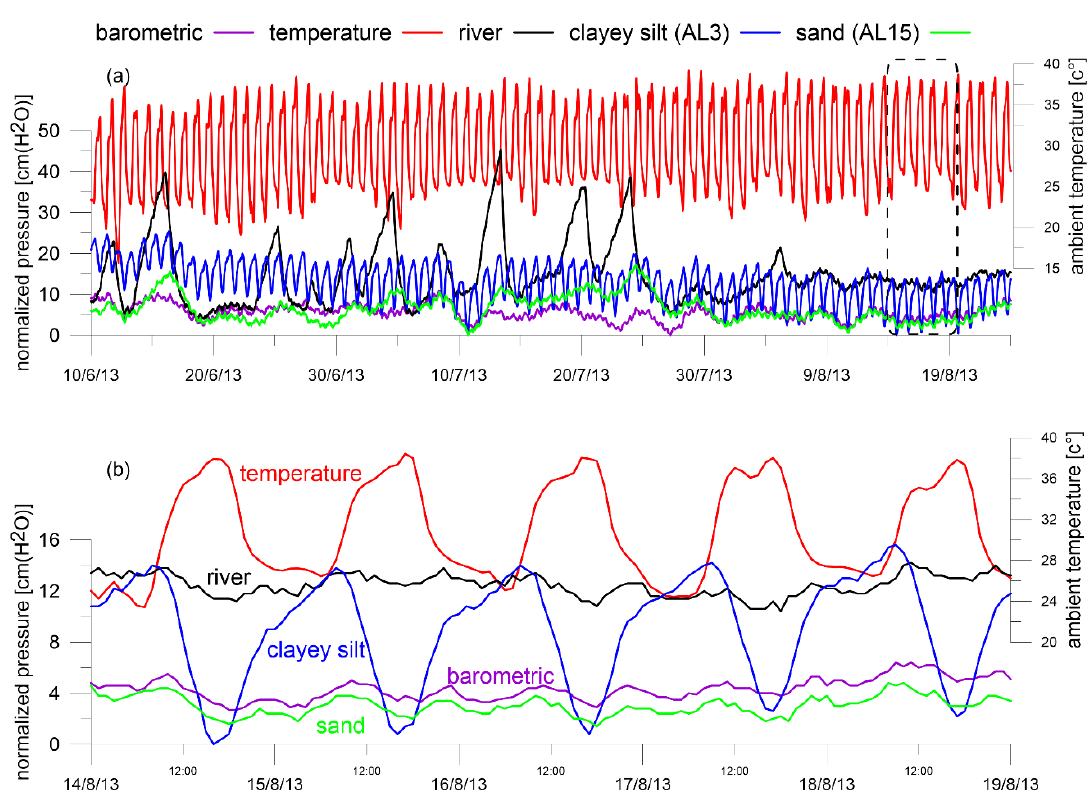
Figure 14. Groundwater level tidal fluctuations at the silty site, compared with groundwater level at the sandy site, and river, as well barometric pressure and temperature. Barometric pressure is normalized to 0 cm (above mesa level). ( b ) Enlargement of the dashed rectangle in the top panel ( a ). A Fourier analysis was carried out on a subset of data between May and August 2013 (Figure